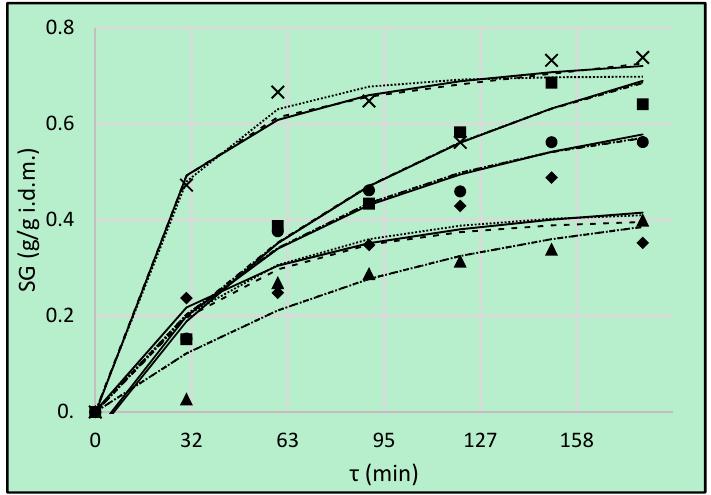
Figure 3. Solid gain ( SG ), kinetics using different solutions: erythritol ( (cid:4) ), xylitol ( ● ), maltitol ( ▲ ), dihydroxyacetone ( ♦ ), sucrose ( ). Lines are the Peleg’s model (solid lines), the Kelvin–Voigt model (dotted lines) and Burgers Model (dashed lines). Table 5. The influence of osmotic agents and pre-treatment time on solid gain during OD. Factor p